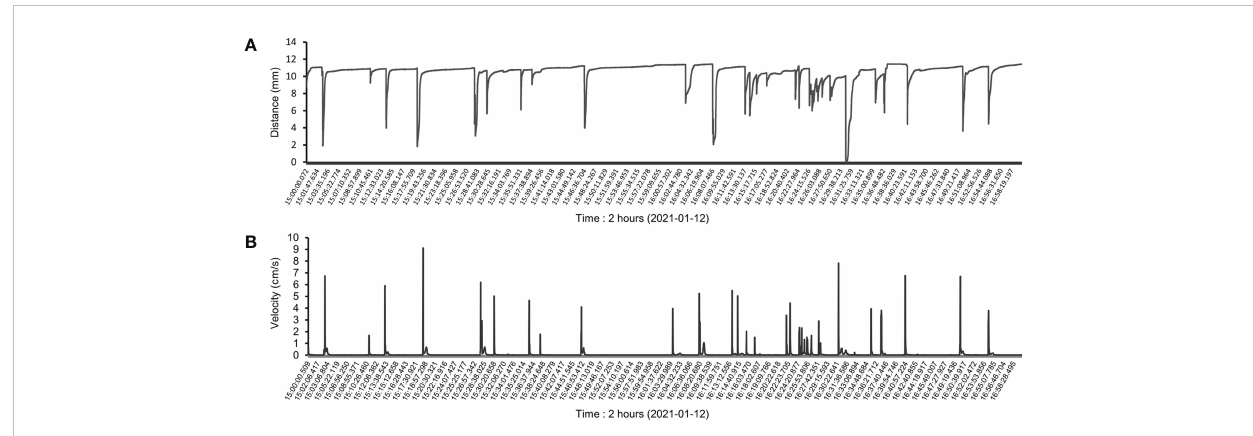
FIGURE 2 Partial raw data for scallop valve movements. (A) Two-hour raw distance data were selected from one continuous monitoring sample to display partial behavioral patterns of scallop valve movements. (B) Coincident with the patterns above, the velocities of valve movements were calculated based on the distance data, re fl ecting the intensity of each valve movement.